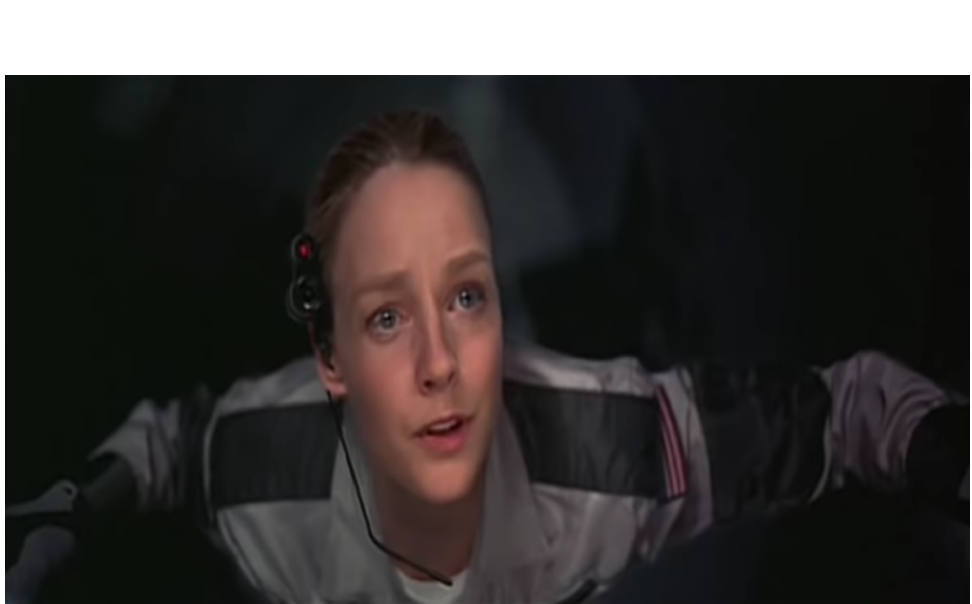
Figure 4: Contact . A mystical cosmic